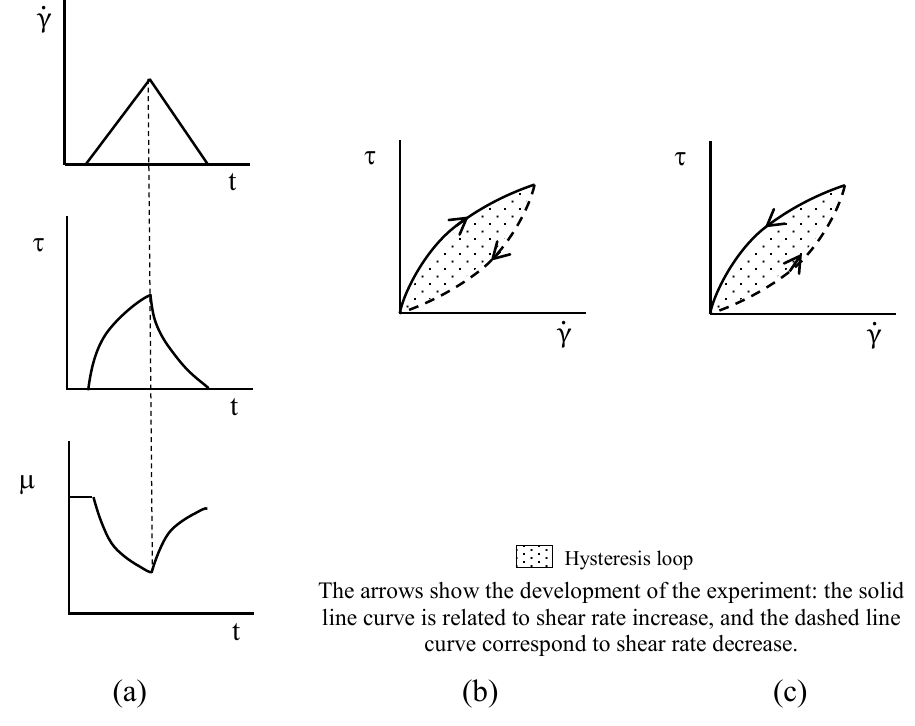
Figure 7: Loop test: (a) Shear rate, stress and viscosity as a function of time for an ideal (inelastic) thixotropic fluid; (b) Stress as a function of shear rate for thixotropic material; (c) Stress as a function of shear rate for rheopectic material. Modified from [1] and [3]